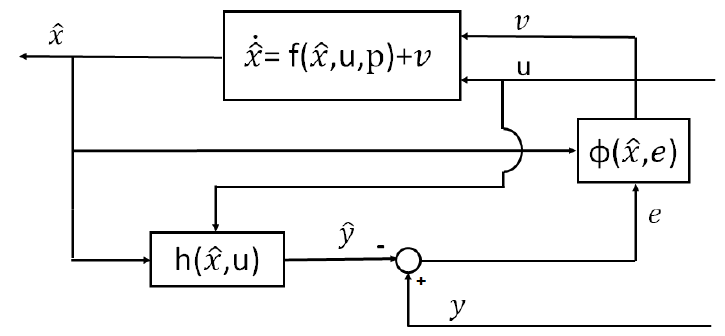
Figure 6. State observer